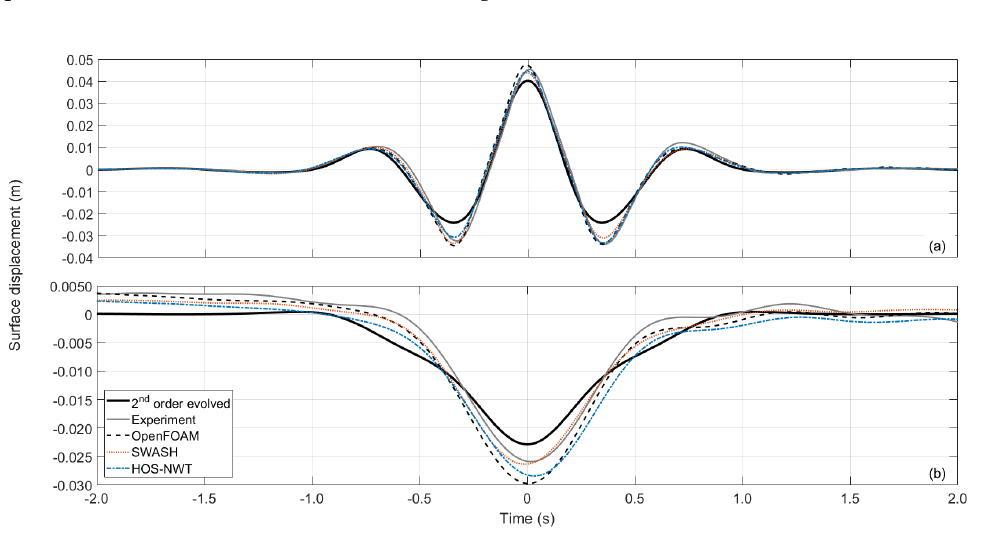
Figure A1. Comparison of the free surface elevation of the calculated and extracted 2 nd order harmonics at the PF location: ( a ) 2 nd sum; ( b ) 2 nd diff.